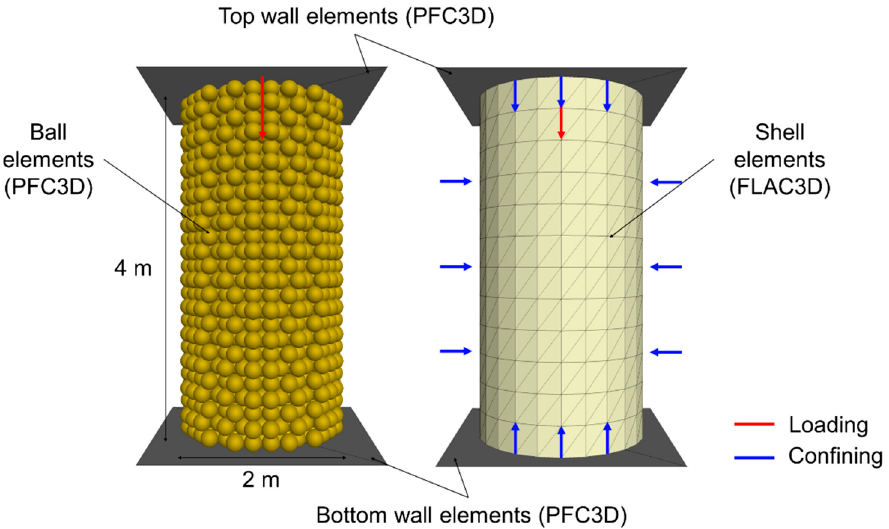
Figure 4. Large-scale triaxial test model for calibration of contact parameters.